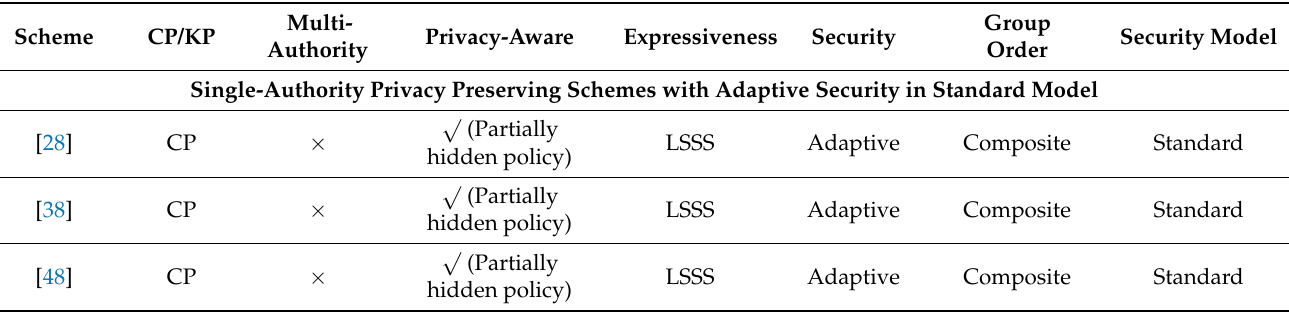
Table 1. Prominent ABE schemes vs. SP-MAACS